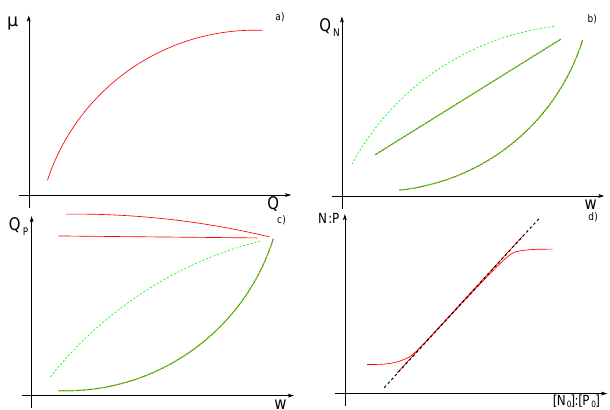
Fig. 1. Qualitative plot of the patterns for growth rate µ and quotas Fig.1. Qualitativeplotofthepatternsforgrowthrate (cid:22) andquotas Q observedintheexperimentalliterature(seeTables1and2). In panels a to c , when the behavior observed under N limitation is different from that under P limitation, two colors and line Q observed in the experimental literature (see Tables 1 and 2). In stylesareused, withgreendashedlinesindicatingphosphoruslimitation. (a) Saturatingformforthegrowthratedependenceon limitingnutrients. (b) , (c) Dependenceofthequotasondilutionrate,withasymmetricbehaviorforNlimitation. (d) Responseof panels (a) to (c) , when the behavior observed under N limitation is phytoplankton N:P ratiotochangesintheinputratio;theblacklinerepresents N:P=[N 0 ]:[P 0 ] .SeeTables1and2forreferences. different from that under P limitation, two colors and line styles are used, with green dashed lines indicating phosphorus limitation. (a) Saturating form for the growth rate dependence on limiting nutri- ents. (b) , (c) Dependence of the quotas on dilution rate, with asym- metric behavior for N limitation. (d) Response of phytoplankton N : P ratio to changes in the input ratio; the black line represents N : P= [ N 0 ] : [ P 0 ] . See Tables 1 and 2 for 14